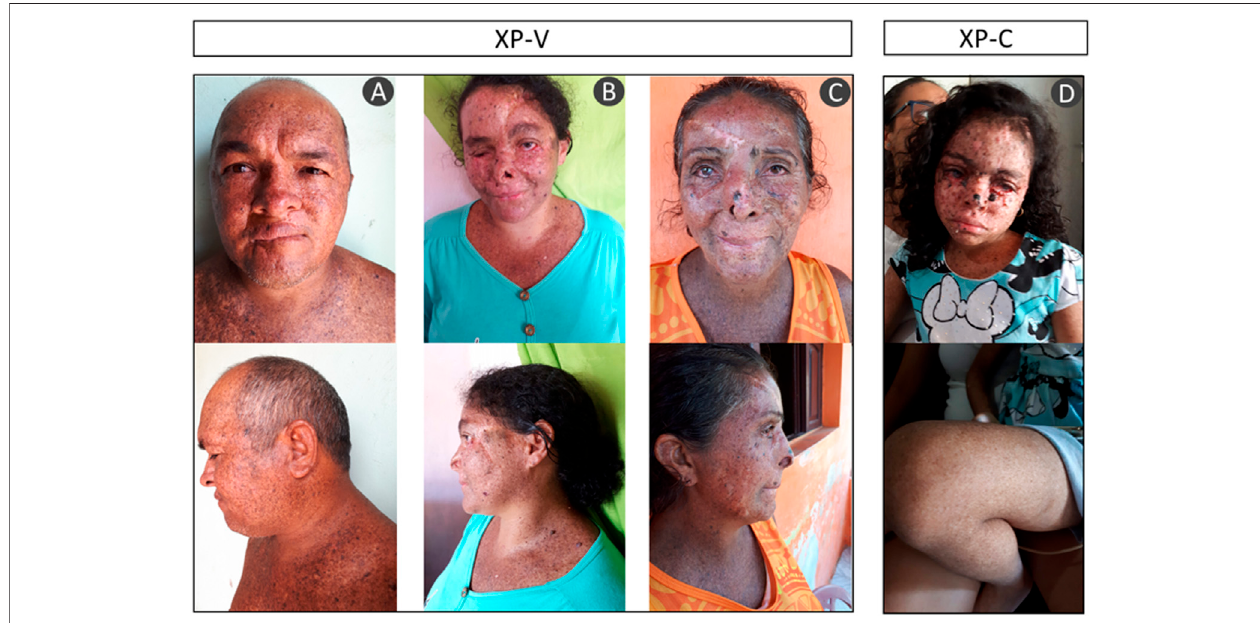
FIGURE 2 | Patient phenotype from three XP-V: (A) XP04RN.br, (B) XP08RN.br, (C) XP06RN.br, and one XP-C (D) XP07RN.br. The pictures are shown with the consent of the patients.